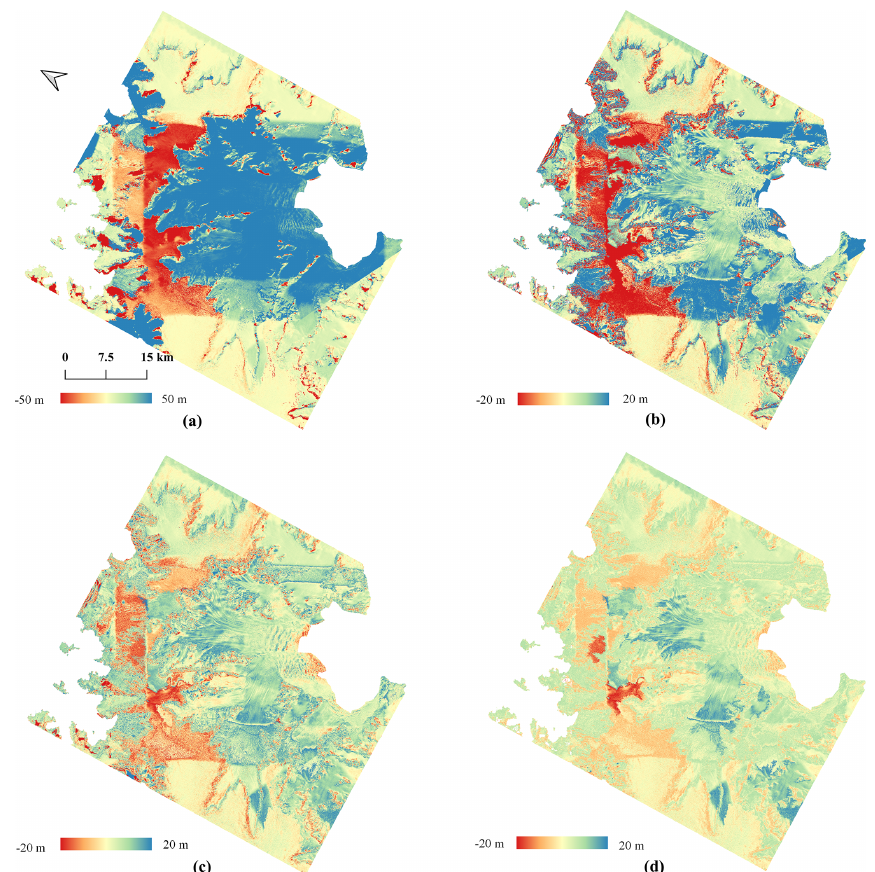
Figure 12. Elevation difference maps of the HG area between the (a) original TDM DEM, (b) TDM DEM after the first correction, (c) TDM DEM after the second correction and (d) TDM DEM after the third correction and the REMA mosaic. Elevation difference: TDM DEM minus REMA mosaic.